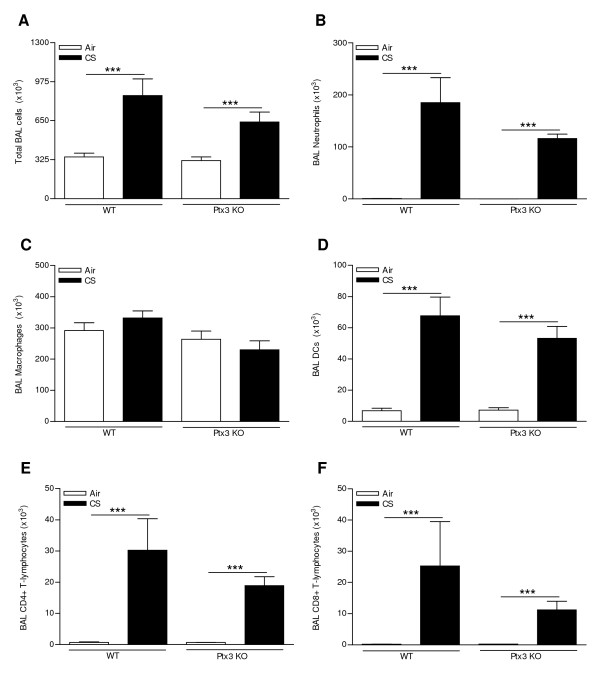
Effect of subacute (4 weeks) cigarette smoke (CS) exposure and PTX3 deficiency on the cell subsets in bronchoalveolar lavage (BAL) fluid. (A) Total cell numbers and numbers of (B) neutrophils, (C) macrophages, (D) dendritic cells, (E) CD4+ and (F) CD8+ T-lymphocytes in WT and Ptx3 KO mice upon 4 weeks exposure to air or CS. Results are expressed as mean ± SEM (N = 10 animals/group; *** p < 0.001). All cell types were enumerated by flow cytometry, except for the neutrophils which were determined by cytospin counts.